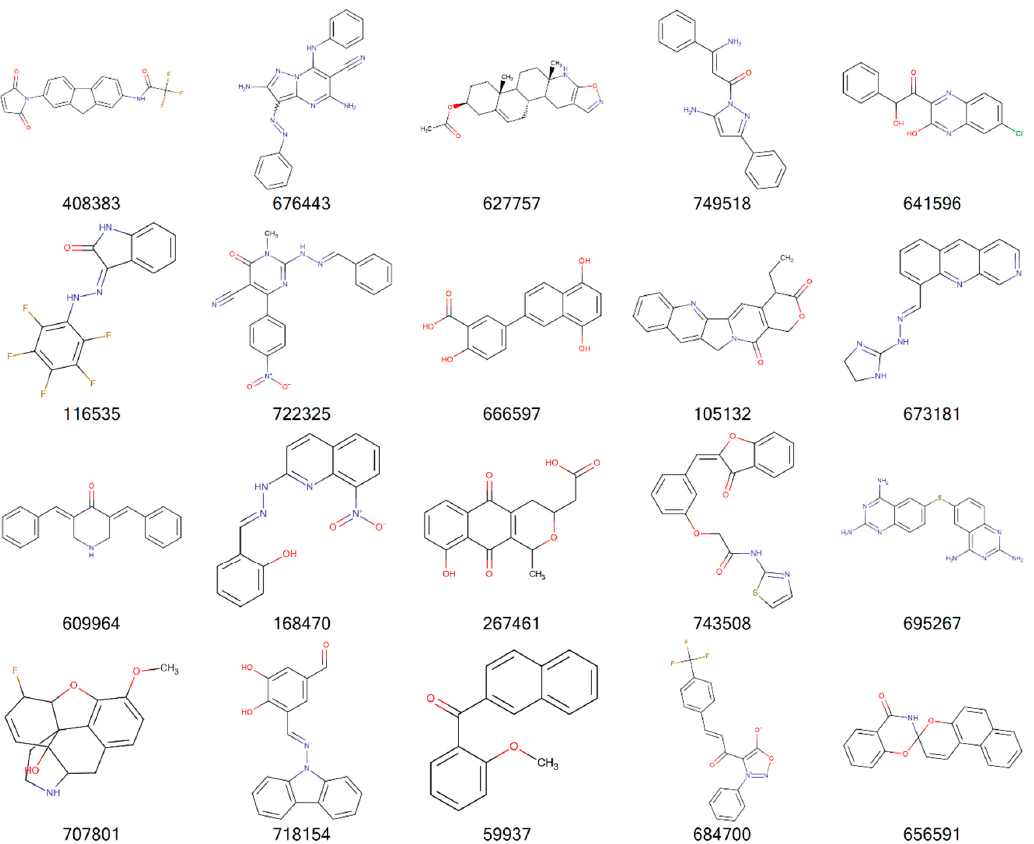
Figure 2. 2D structures of top 20 drug-like ligands for AML. Listed are NSC-408383, NSC-676443, NSC-627757, NSC-749518, NSC-641596, NSC-116535, NSC-722325, NSC-666597, NSC-105132, NSC-673181, NSC-609964, NSC-168470, NSC-267461, NSC-743508, NSC-695267, NSC-707801, NSC-718154, NSC-59937, NSC-684700, and NSC-656591.